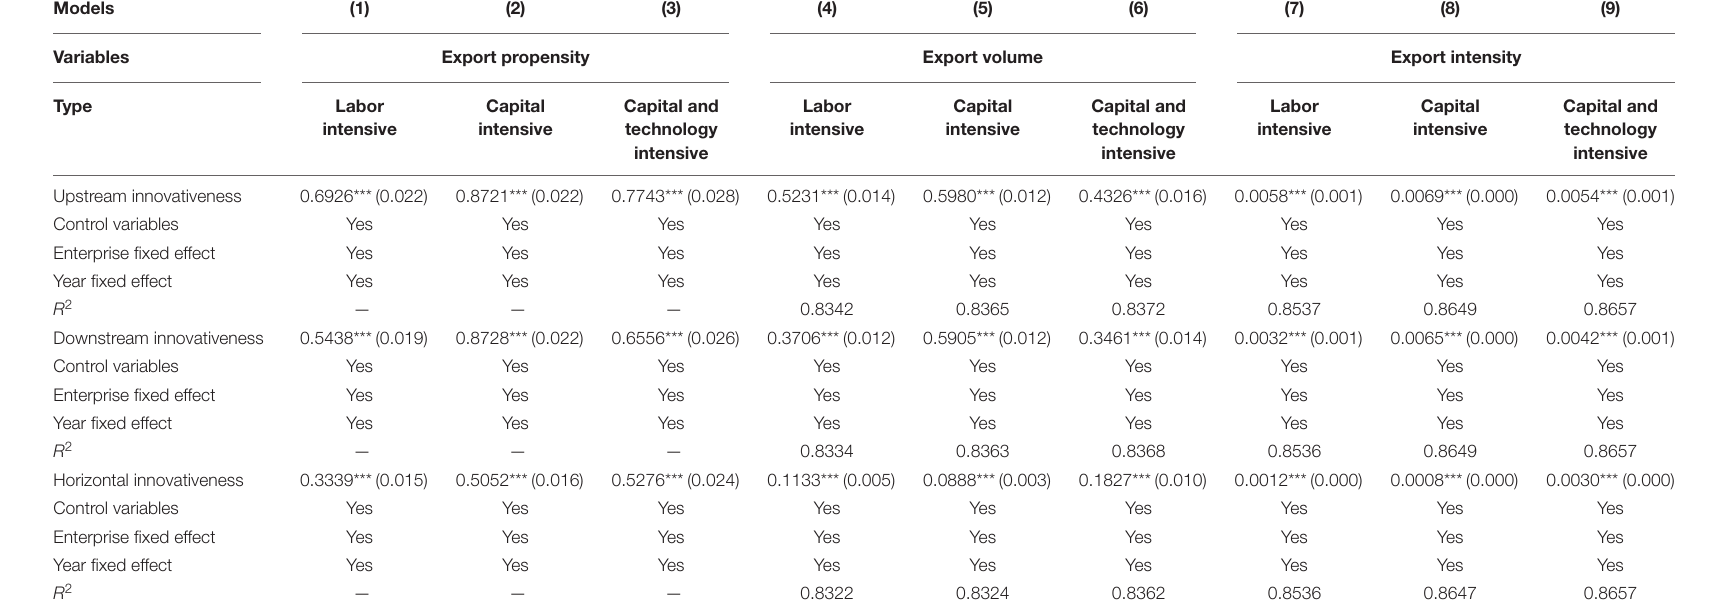
TABLE 3 | Heterogeneity analysis by